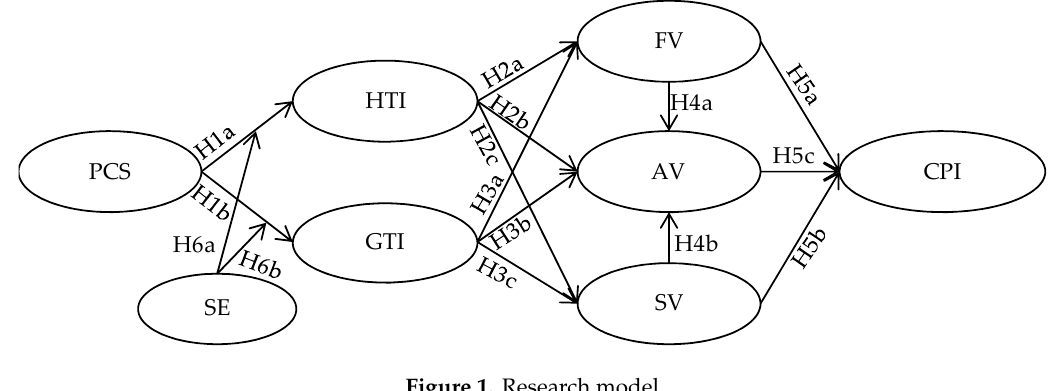
Figure 1. Research model.